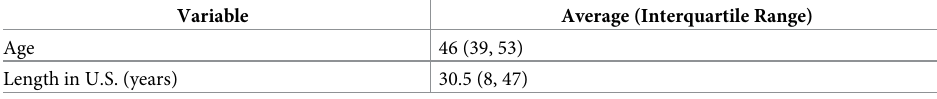
Table 2. Sample descriptive statistics continuous variables ( n =